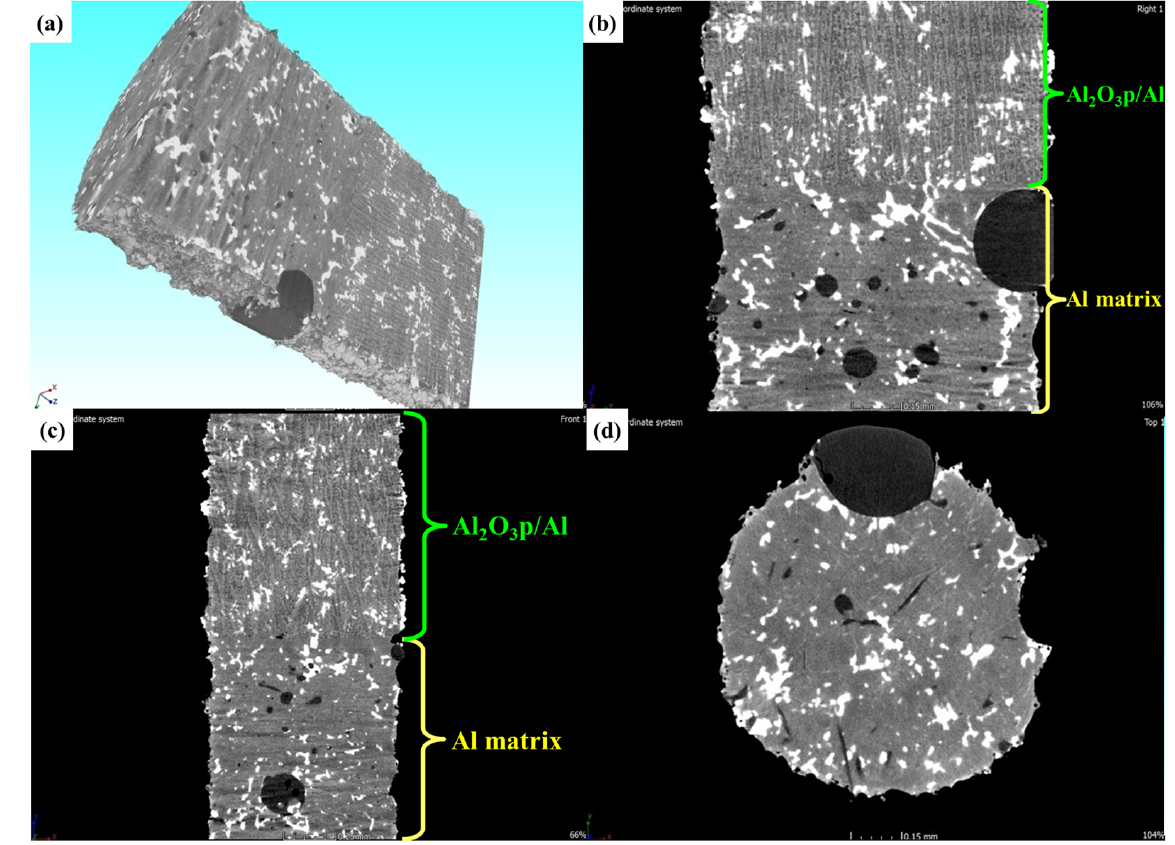
Figure 3: X-ray CT characterization of the lamellar Al 2 O 3 p/Al composite. (a) 3D-image, (b)(c) Cross-section images observed perpendicular to the freezing direction, (d) Cross-section images observed parallel to the freezing direction.